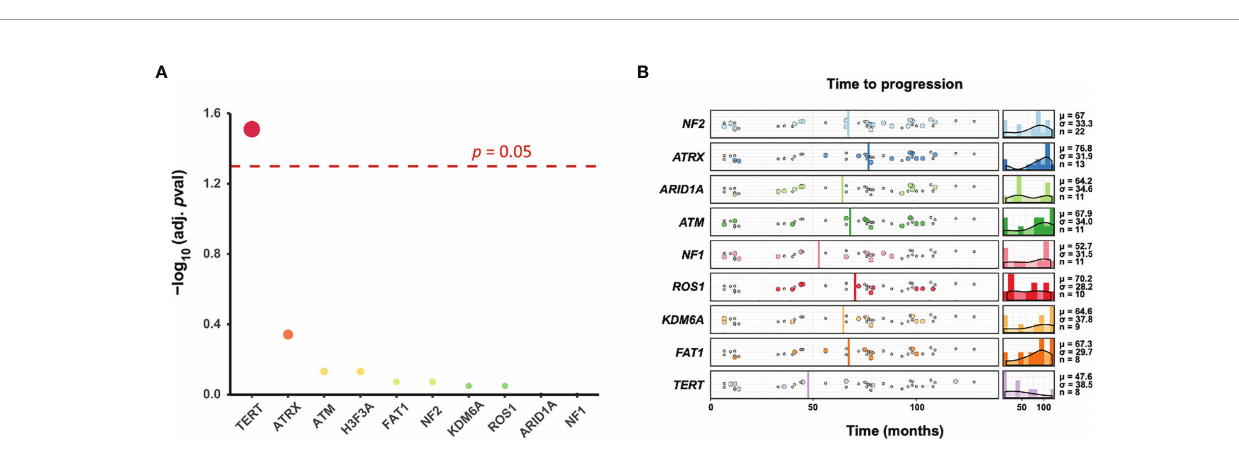
FIGURE 3 | TERT mutations predict tumor progression of de novo high-grade meningiomas (HGMs) following radiotherapy (RT). (A) Association of recurrent mutations with tumor progression. Fisher ’ s test was utilized to detect differentially mutated genes on top 9 most frequent mutation genes between two cohorts (progression vs. non-progression). The point size in dotplot corresponds to the -log10(adj. p -val) value, together with the red color indicates the higher -log10(adj. p - val) value, and blue indicates the lower value. Horizontal dash line marked the p -value 0.05. (B) Timing of tumor progression. Shown is the time to progression (colored dots) or last progression-free scan (gray dots) for top 9 most frequent mutation genes in months. The average progression time was depicted in vertical line. The average time to recurrence of TERT mutant meningiomas was less than other tumors (Wilcoxon rank sum test with continuity correction, W = 491, p = 0.0864). Density plot of each subgroup ’ s progression is shown on the right, along with the mean ( m ), standard deviation ( s ), and number of progression